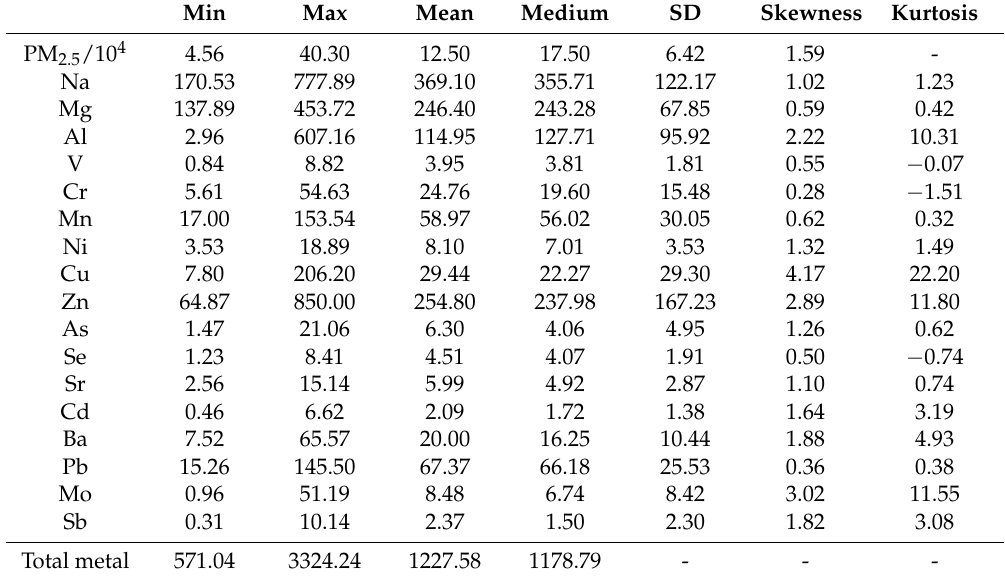
Table 1. Concentrations of PM 2.5 metal elements in suburban Nanjing during 2012–2013 (ng/m 3